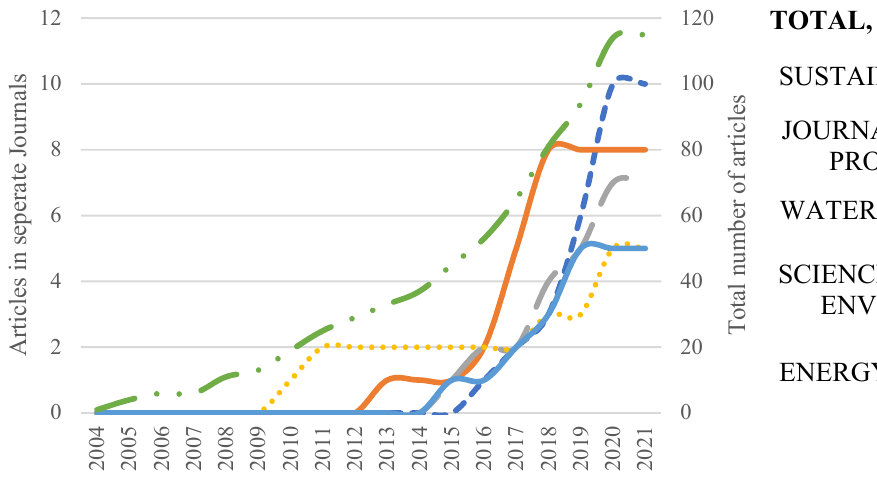
Figure 2. Article Figure 2. Article trends.